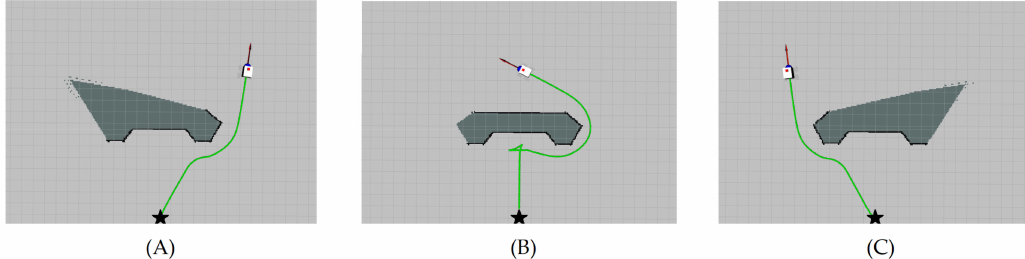
Figure 13. Simulation results of the nonsatisfaction of the FST condition when the selected waypoint is either behind and slightly to the right of the obstacle ( A ), straight ahead and behind the obstacle (local-minima configuration) ( B ), or behind and slightly to the left of the obstacle ( C